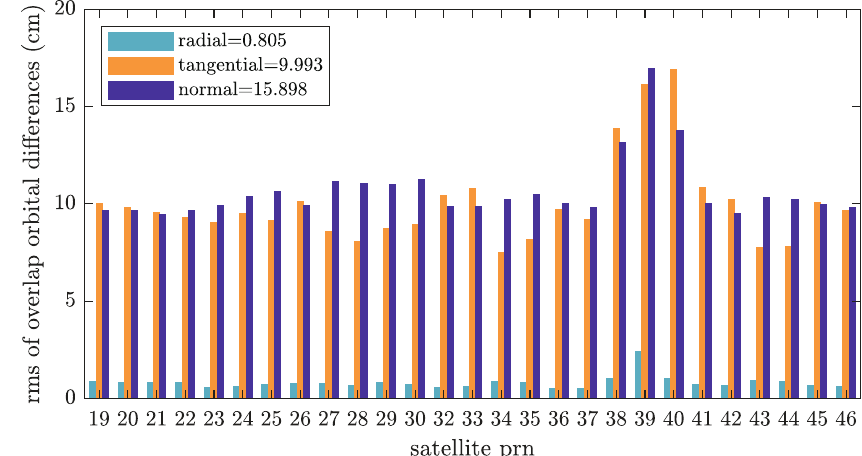
Figure 8: POD accuracy of BDS satellites via ISL